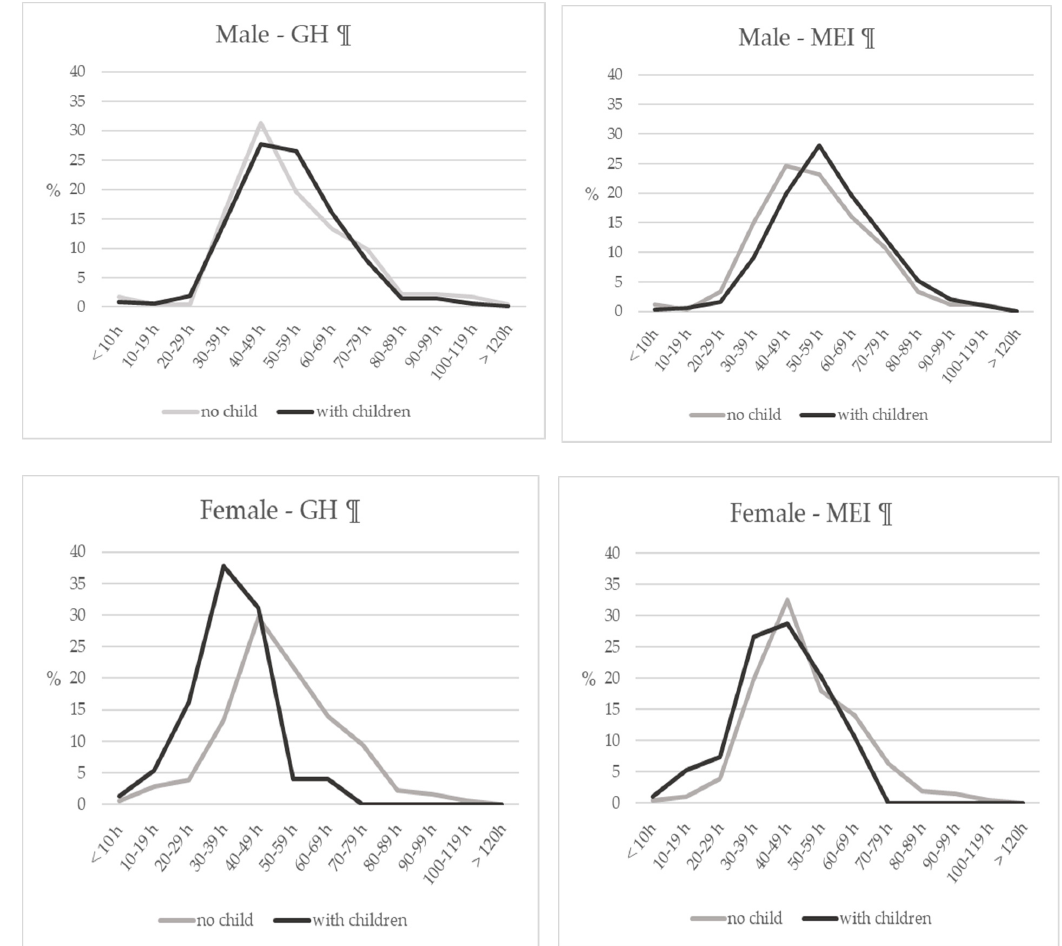
Figure 3. The time distribution of average weekly working hours depending on whether or not dentists live with their children. GH: general hospital, MEI: medical educational